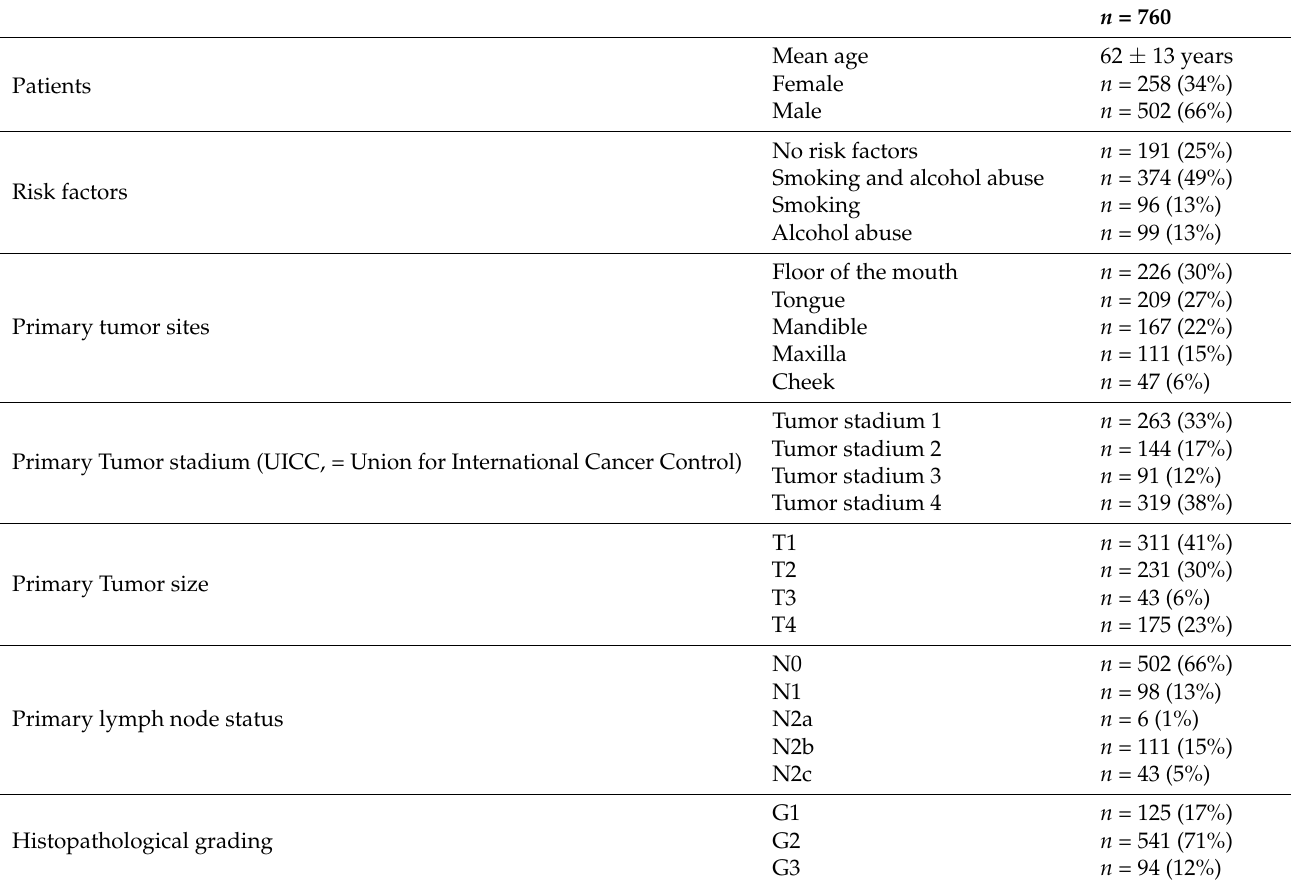
Table 1. Epidemiological data of the patients analyzed in this study ( n = 760).